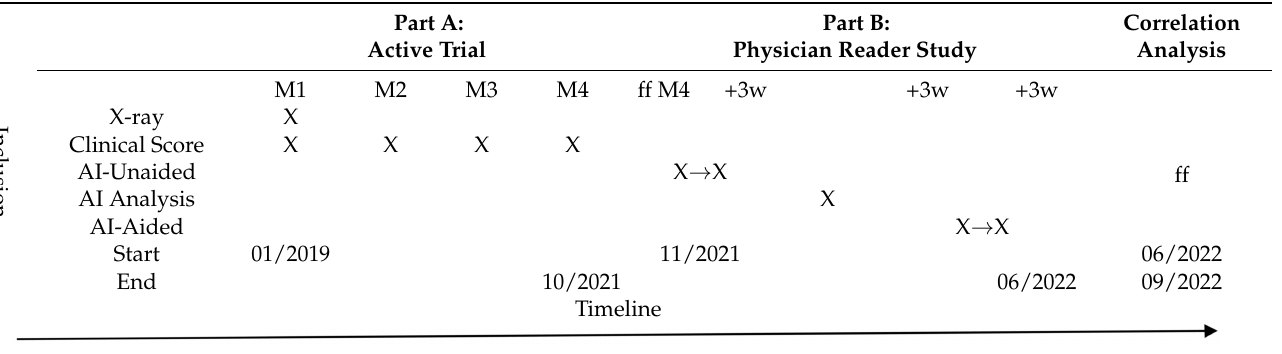
Study design, timeline and workflow (AI = artificial intelligence; ff = following; M = measurement; w = week. “X” marks when outlined task was conducted; → = arrow indicates “new random order of DICOMs in between readings”).